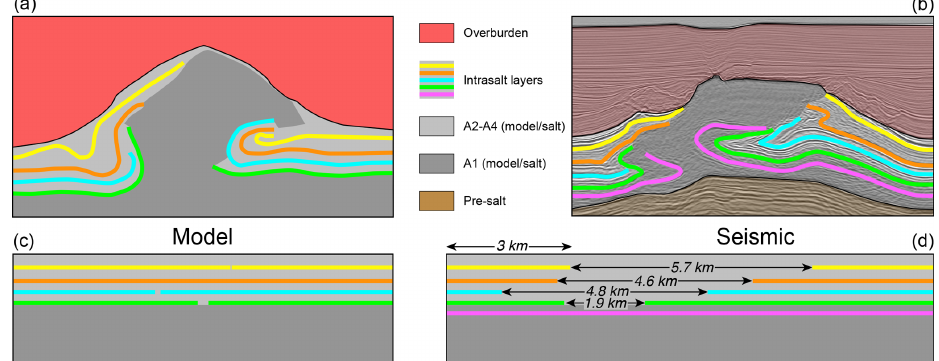
Figure 16. Analog model and seismic profile from the Santos Basin: (a) simplified results of analog model, where A1 is pure silicone polymer and A2–A4 are a mixture of polymer and stronger, more dense granular interlayers (adapted from Dooley et al., 2015); (b) time-migrated 3-D seismic profile at approximately 1 : 1 scale, with the analogous A1 and A2–A4 layers (adapted from Jackson et al., 2015) – the purple line is an extra layer within the A1 unit and is part of the B3 sequence of Fiduk and Rowan, 2012); (c) line-length restoration of the analog model of panel (a) showing that layers fit back together; (d) line-length restoration of the seismic profile of panel (b) , with an extra 3km of the purple layer and missing lengths of the shallower layers. Restorations carried out in Move ™